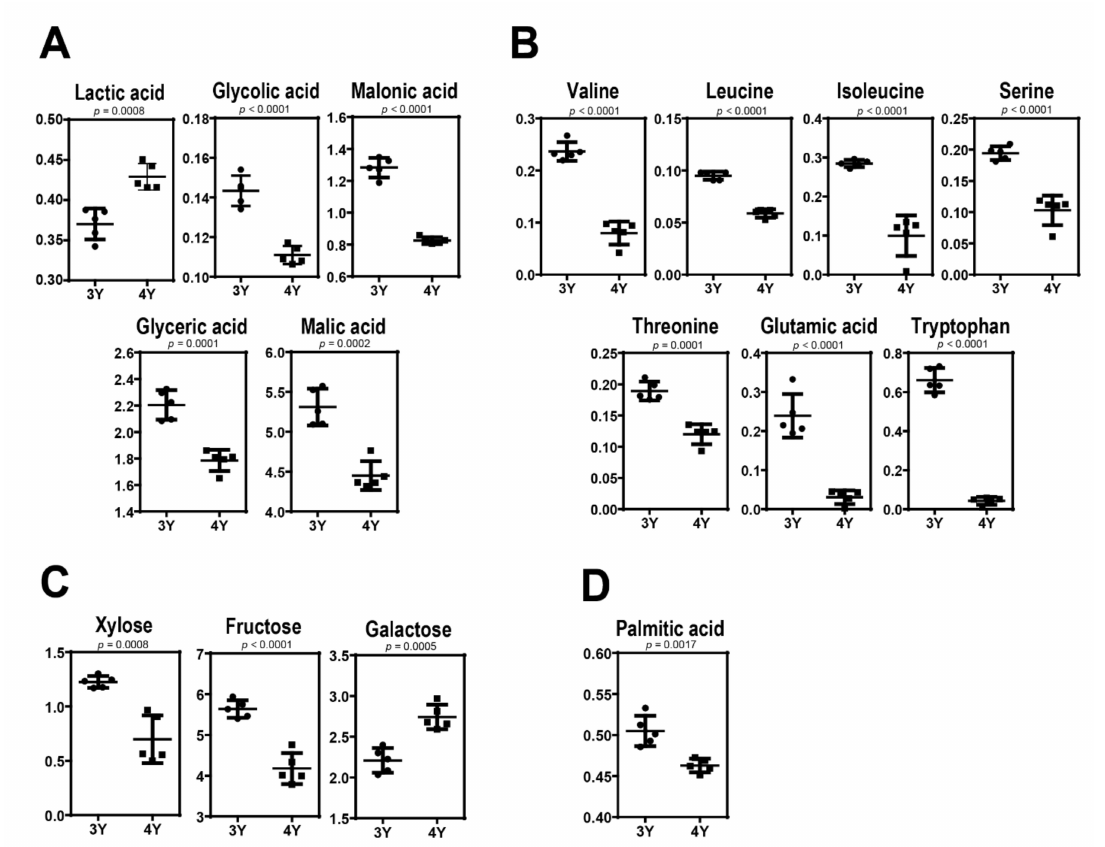
Figure 4. Scatter dot plots in levels of ( A ) organic acids, ( B ) amino acids, ( C ) sugars, and ( D ) fatty acid between three-year-old GB and four-year-old GB at the fifth harvest